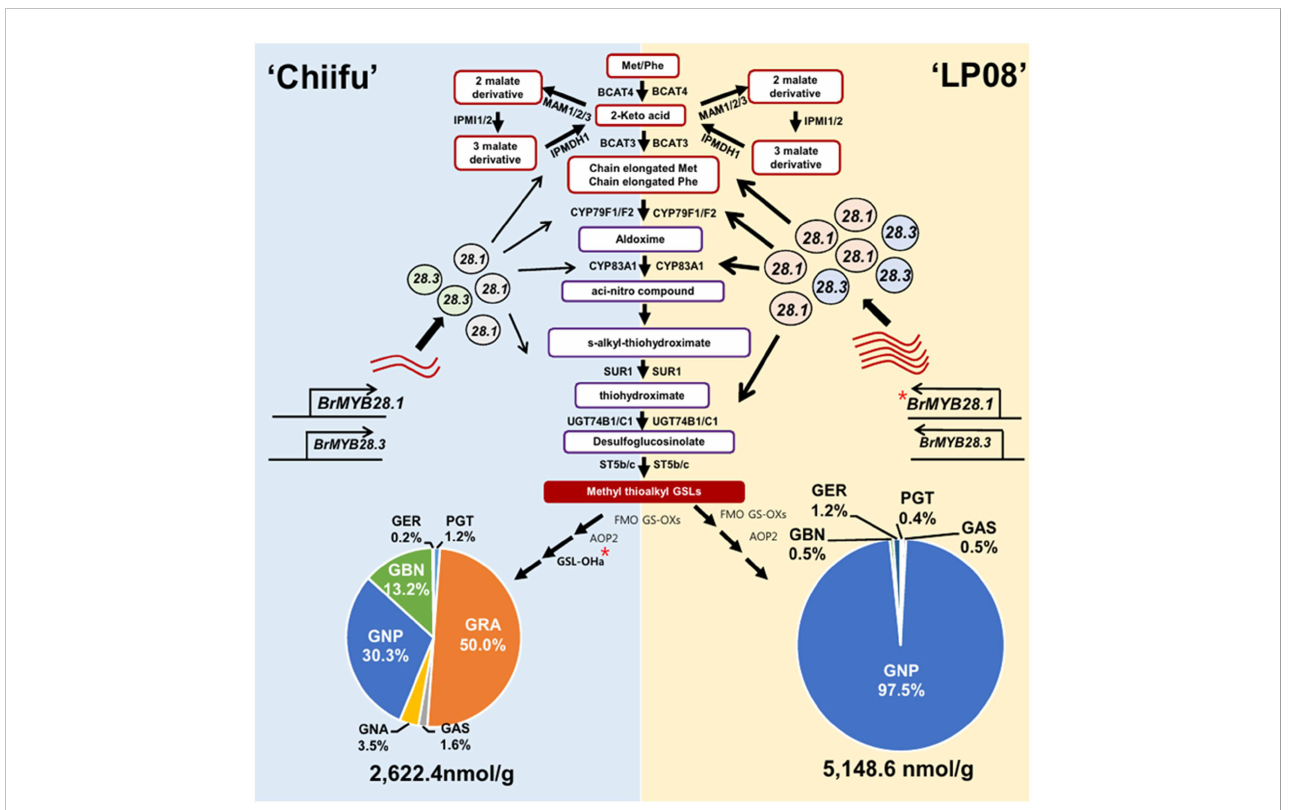
FIGURE 9 Schematic of the molecular mechanisms underlying the differing GSL pro fi les between vegetable-type ‘ Chiifu ’ and oilseed-type ‘ LP08 ’ . The aliphatic GSL biosynthetic pathways of ‘ Chiifu ’ (left) and ‘ LP08 ’ (right) are represented on blue and yellow backgrounds, respectively. Three BrMYB28 homologs play a positive role in the transcription of downstream GSL metabolic genes. Compared to ‘ Chiifu ’ , ‘ LP08 ’ had higher expression of BrMYB28.1 (as well as BrMYB28.3 ), which stimulated downstream GSL metabolic genes. As a result, total amounts of aliphatic GSLs were signi fi cantly higher in ‘ LP08 ’ than ‘ Chiifu ’ . In addition, GSL-OH.1 was uniquely expressed in ‘ Chiifu ’ and not ‘ LP08 ’ , which may contribute to the differing compositional pro fi les of aliphatic GSLs between these two lines. ‘ Chiifu ’ has three major aliphatic GSL compounds accounting for large portions of its total aliphatic GSLs, whereas ‘ LP08 ’ possessed a single GSL compound, GNP, accounting for 97.5% of the total aliphatic GSLs. Pie charts are presented as mean ± standard deviation (SD) (n = 3). Red asterisks (*) indicate two genes identi fi ed as major QTL candidates. PGT: progoitrin; GRE: glucoraphenin; GER: glucoerucin, GBN: glucobrassicanapin, GRA: glucoraphanin, GAS: glucoalyssin, GNP: